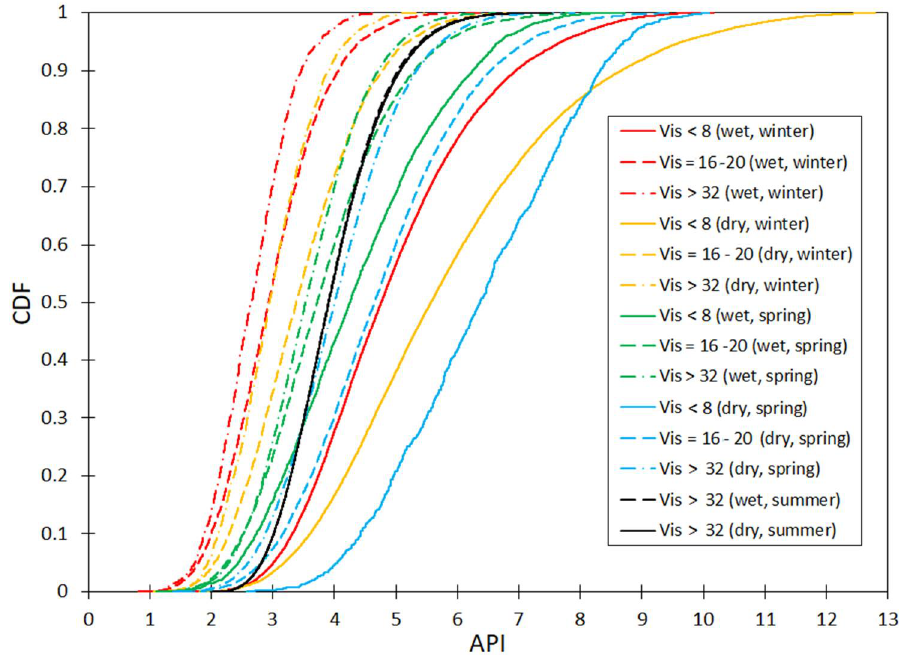
Figure 6. Effect of visibility (Vis), period in annual cycle depending on wet and dry weather on